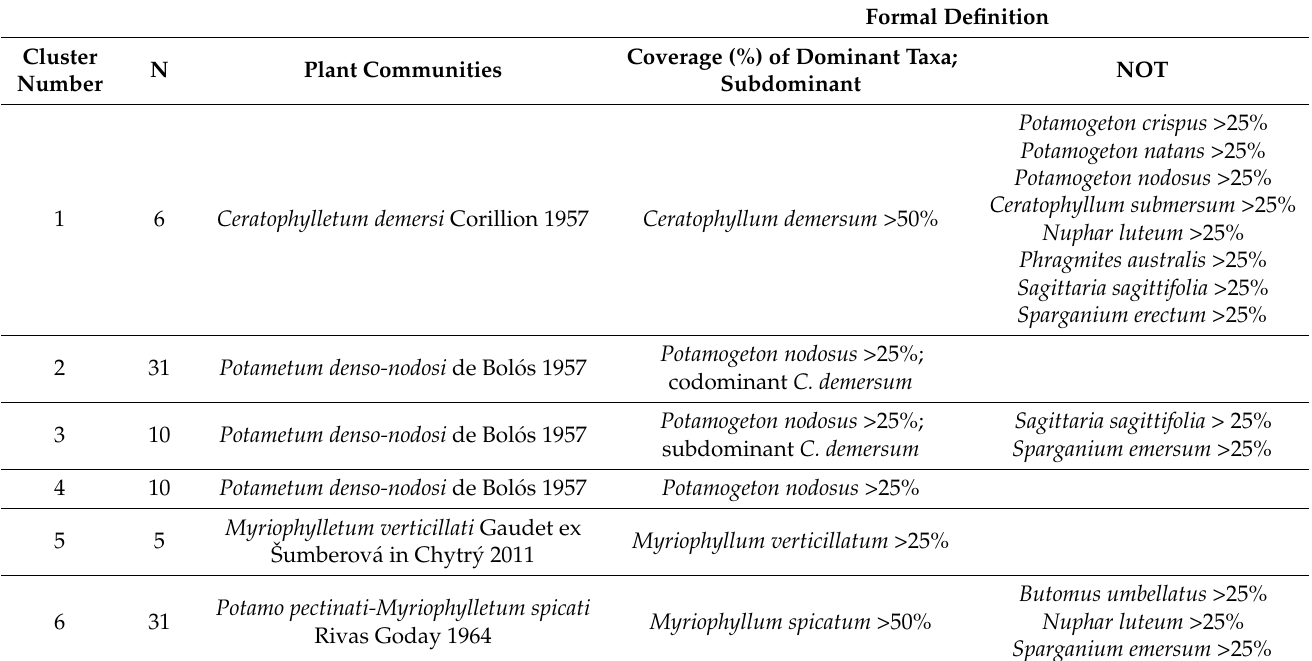
Table 2. Clusters classified into plant communities, their formal definitions as well as dominant and subdominant species.